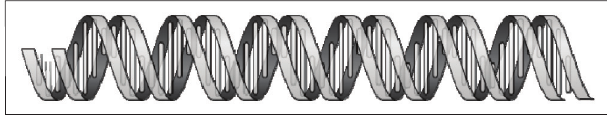
FIGURE 2: Double Helix of Biological DNA